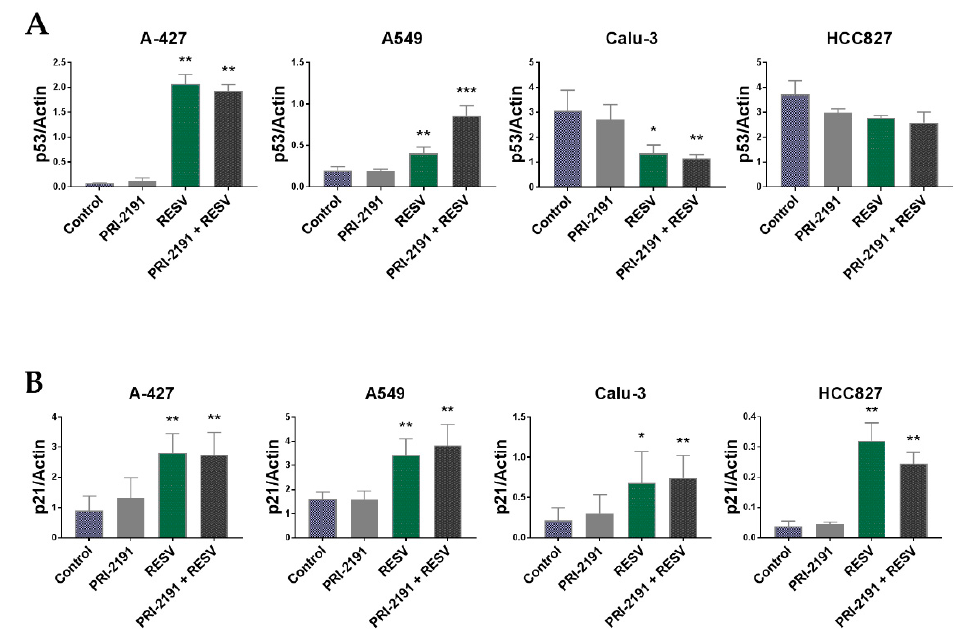
Figure 4. Western blot analysis of lung cancer cells treated with PRI-2191 (100 nM) and RESV (20 µ M). Effect of PRI-2191 and RESV on ( A ) p53 and ( B ) p21 expression in lung cancer cells (all blots and statistical analysis for other cell lines are presented in Figure S6). Cell lysates were subjected to SDS-polyacrylamide gel electrophoresis and analyzed by Western blotting. Actin was used as a normalization control. * Compared to control (untreated cells); ** compared to control and PRI-2191; *** compared to control, PRI-2191, and RESV ( p < 0.05, one-way ANOVA with Tukey’s post hoc with multiple comparisons).